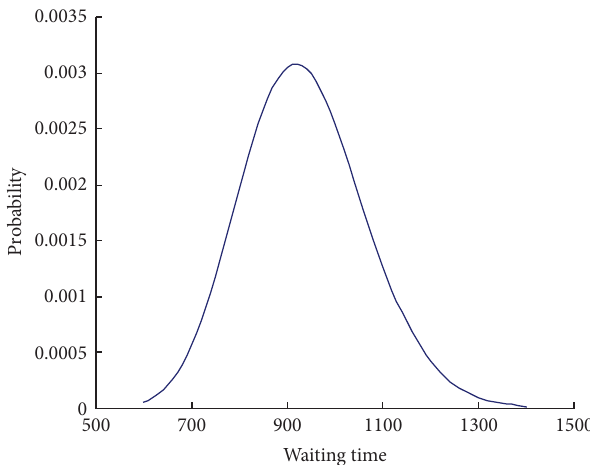
Figure 8: Fitting the waiting time with a Gamma distribution (jobs with 24